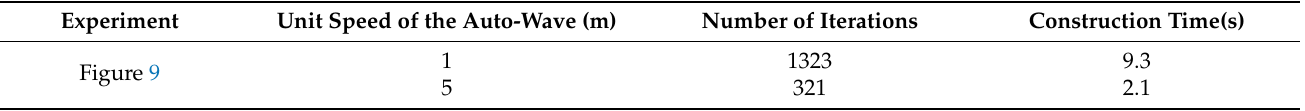
Figure 11. A comparison between the weighted network Voronoi diagram using the model of improved PCNN and that based on the idea of the shortest path. Table 1. Performance parameters of the algorithm for constructing weighted network Voronoi diagrams. Experiment Unit Speed of the Auto-Wave